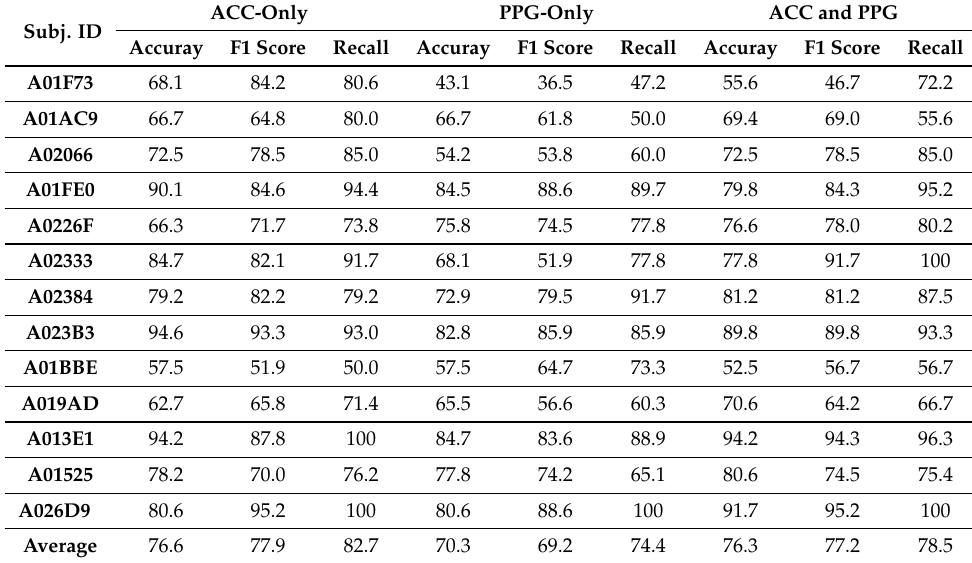
Table 4. Personal Model